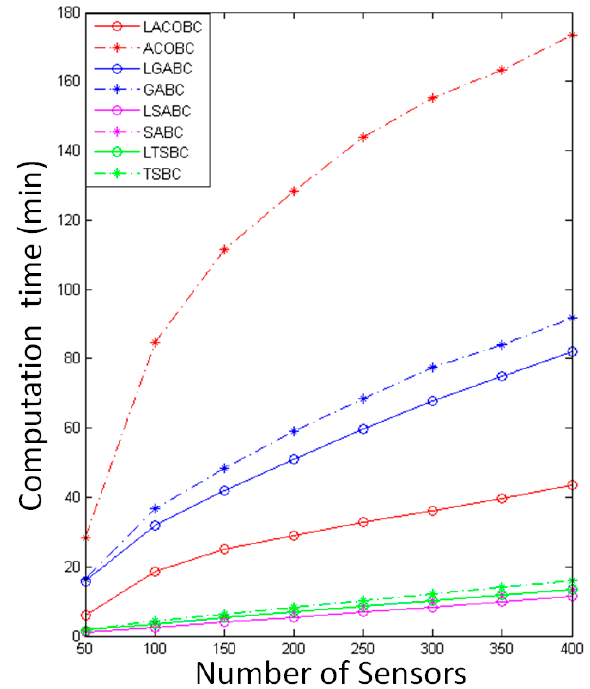
Figure 4. Comparison of computational time.